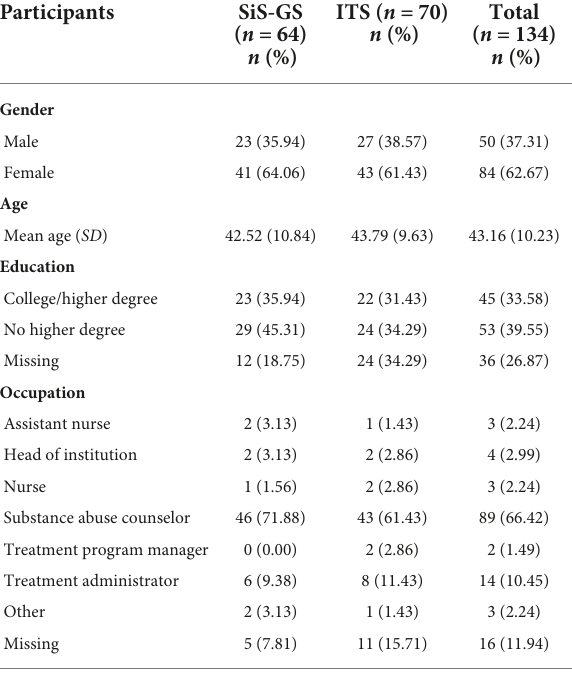
TABLE 1 Baseline characteristics of the enrolled